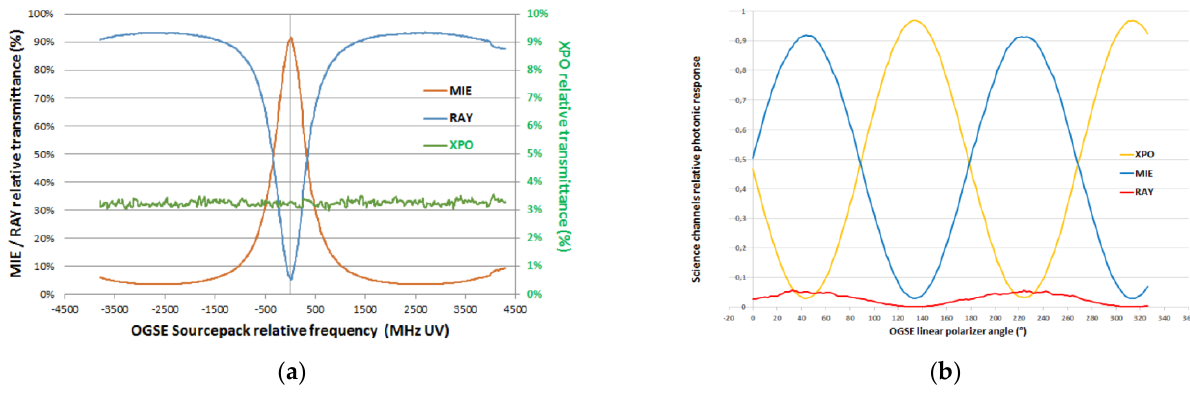
Figure 11. Example of polarisation measurements performed during TVAC; channels’ relative responses versus: ( a ) OGSE frequency scan; ( b ) OGSE linear polarisation rotation.